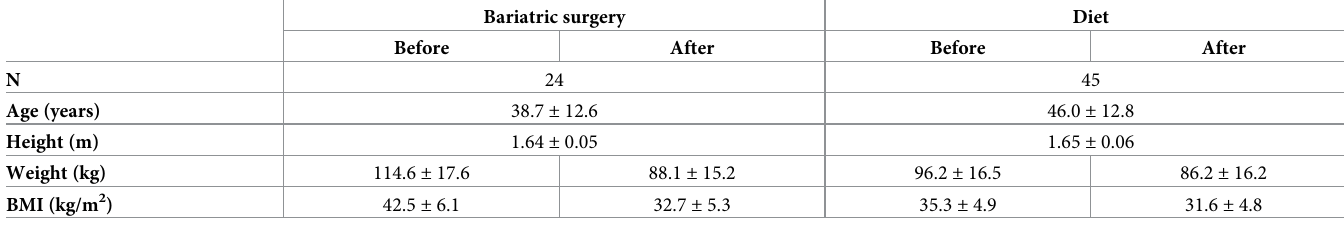
Table 2. Patient characteristics of study cohort